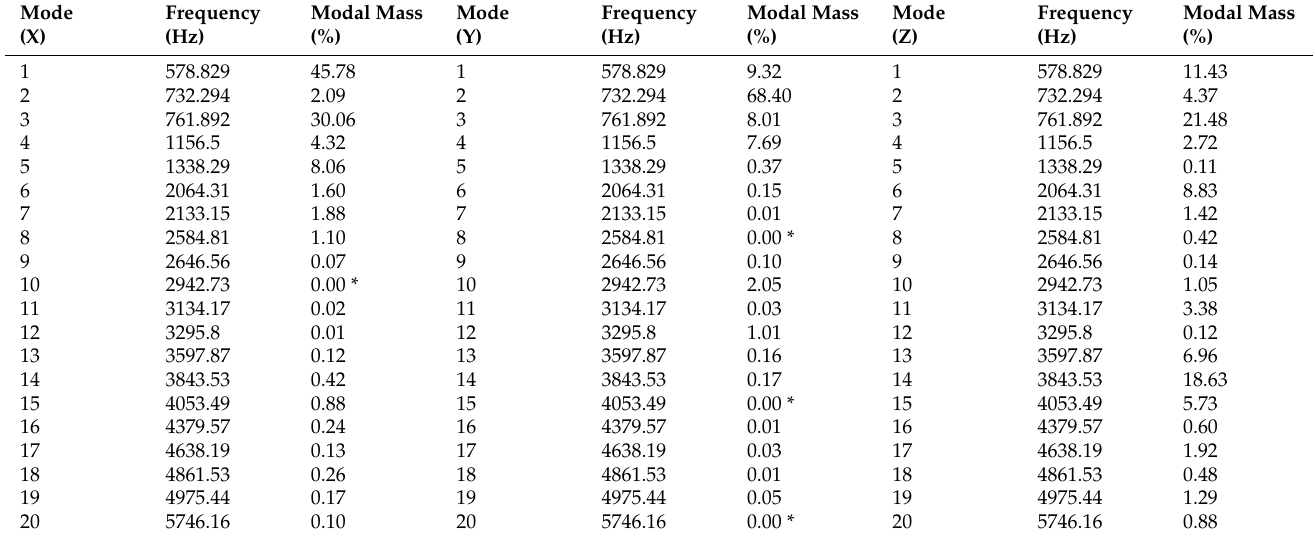
Table 2. Mode extraction.